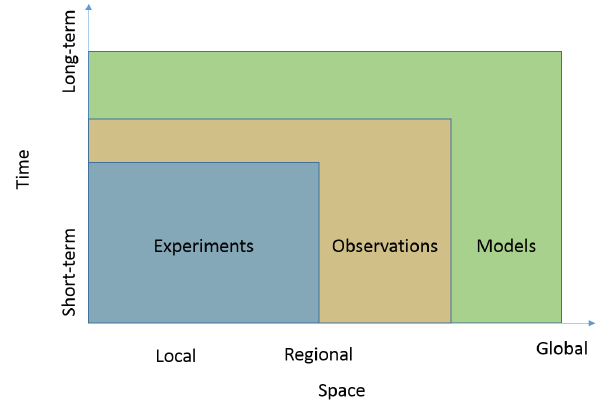
Figure 3. Temporal and spatial scales at which different research approaches are appropriate (adapted with permission from Reyer et al. (2015), ©Reyer et al. (2015), used under the CC Attribution License